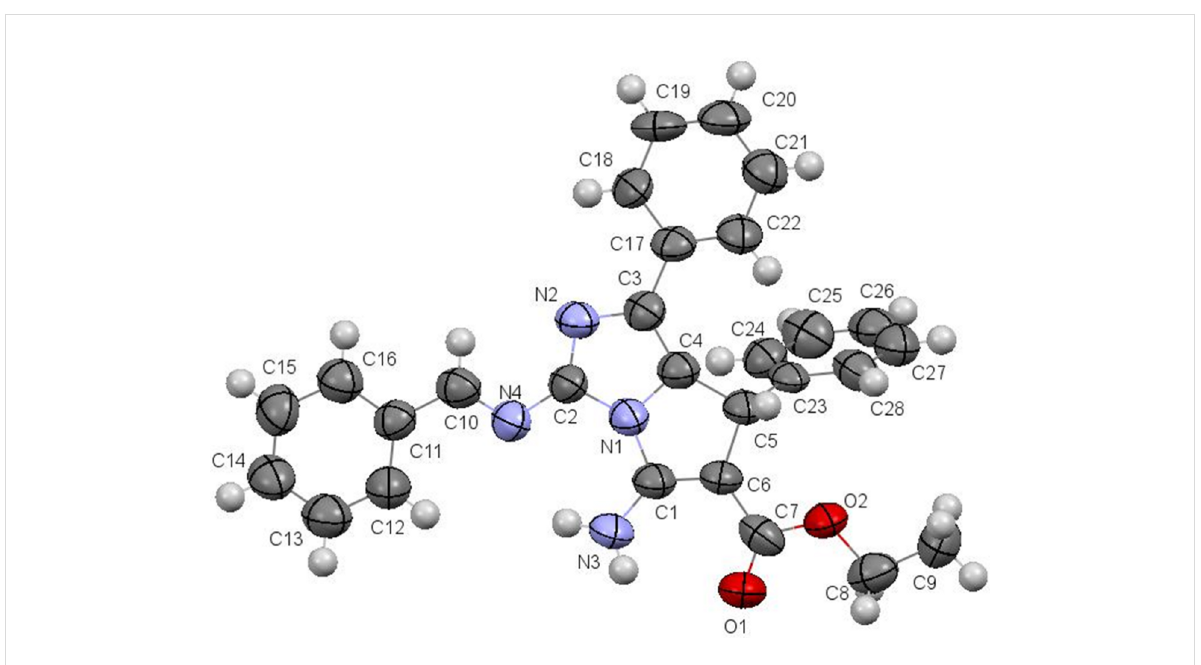
Figure 5: Molecular structure of aminoimidazo[1,2- c ]pyrrole 16a according to X-ray diffraction data. Thermal ellipsoids of atoms are shown at 50% probability level.